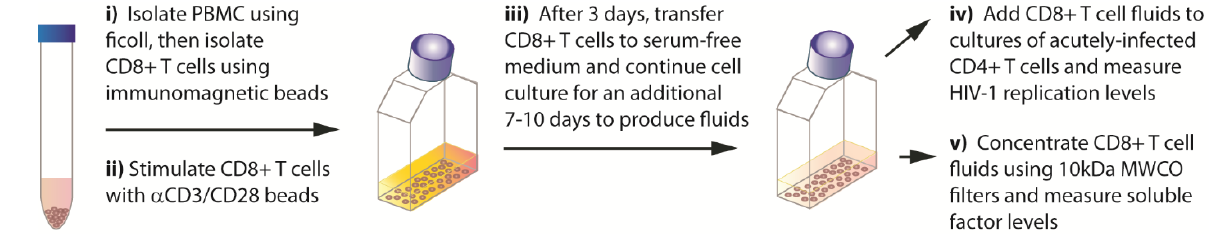
Figure 1. Overview of the procedures used to produce and evaluate CD8+ T cell culture superna-